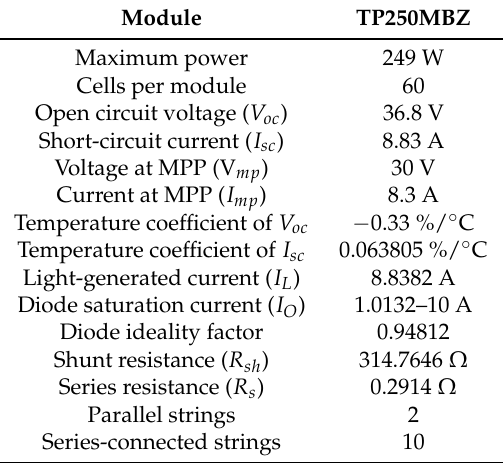
Table 4. PV array for high power simulation